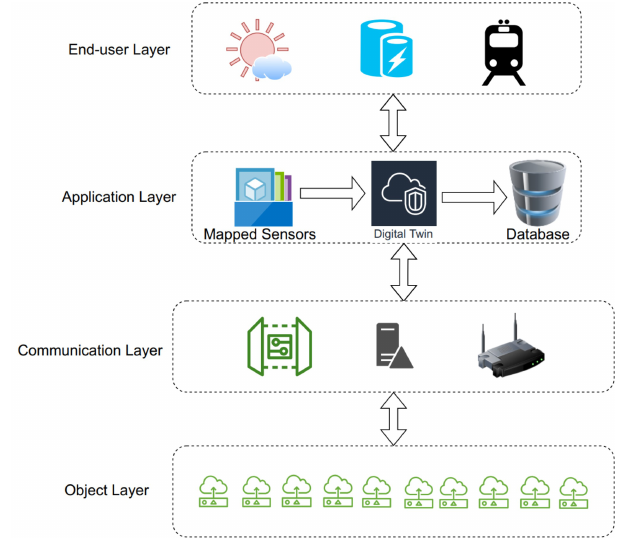
Figure 5. DT architecture for